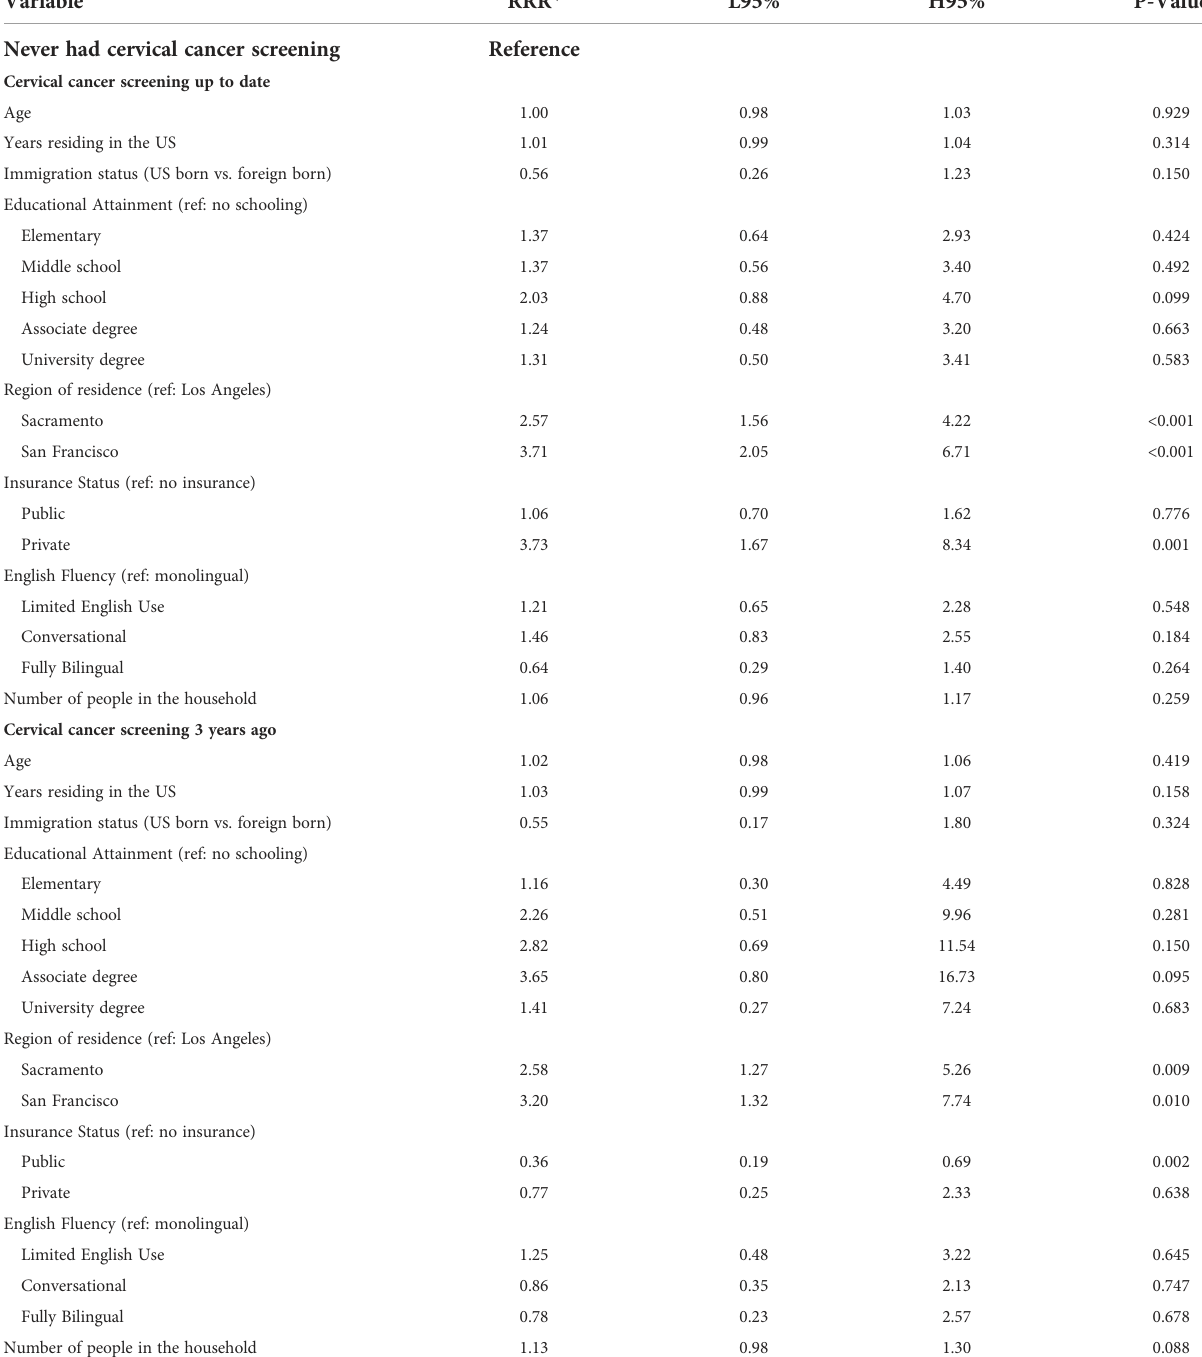
TABLE 5 Multivariate multinomial logistic regression model testing the association between cervical cancer screening behavior and demographic factors among ‘ Tu Historia Cuenta ’ participants ages 21 to 65 (N=932, 80 excluded from 1012 due to missing data). Variable RRR* L95% H95% P-Value Never had cervical cancer screening